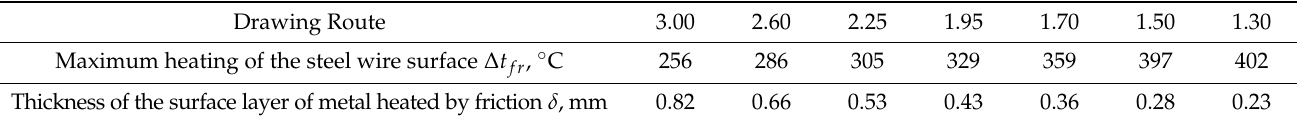
Table 2. Heating of the steel wire surface by friction during drawing.